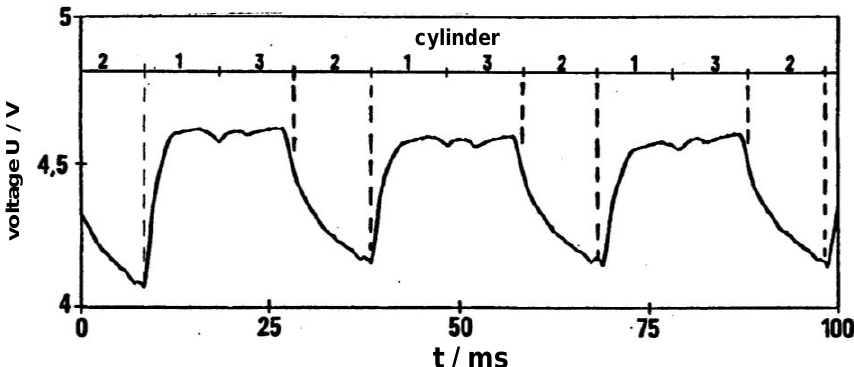
Figure 2. Engine test bench result of a Siemens thin-film sensor [30]. The voltage signal is a result of the changing sensor resistance when operated under different  -values. For further details see